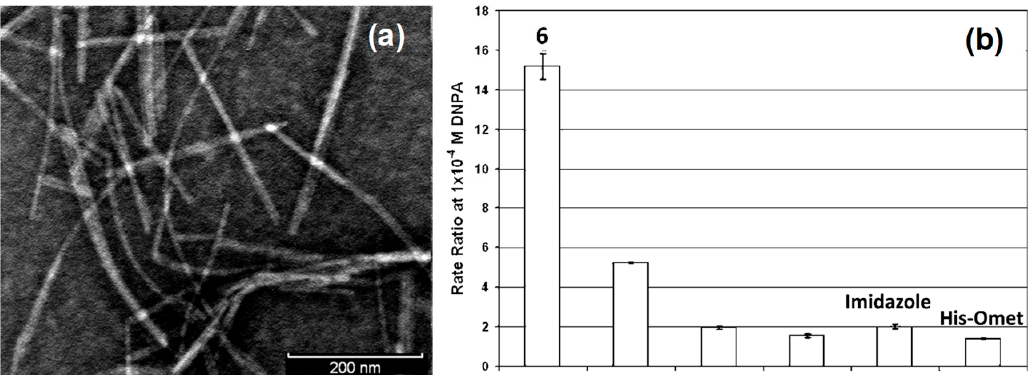
Figure 3. ( a ) Negatively stained TEM micrographs of a gel prepared from 6 ; ( b ) observed rate increase in DNPA hydrolysis as the level of molecular organization in the catalytic particles is varied. Reproduced with permission from Reference [63].